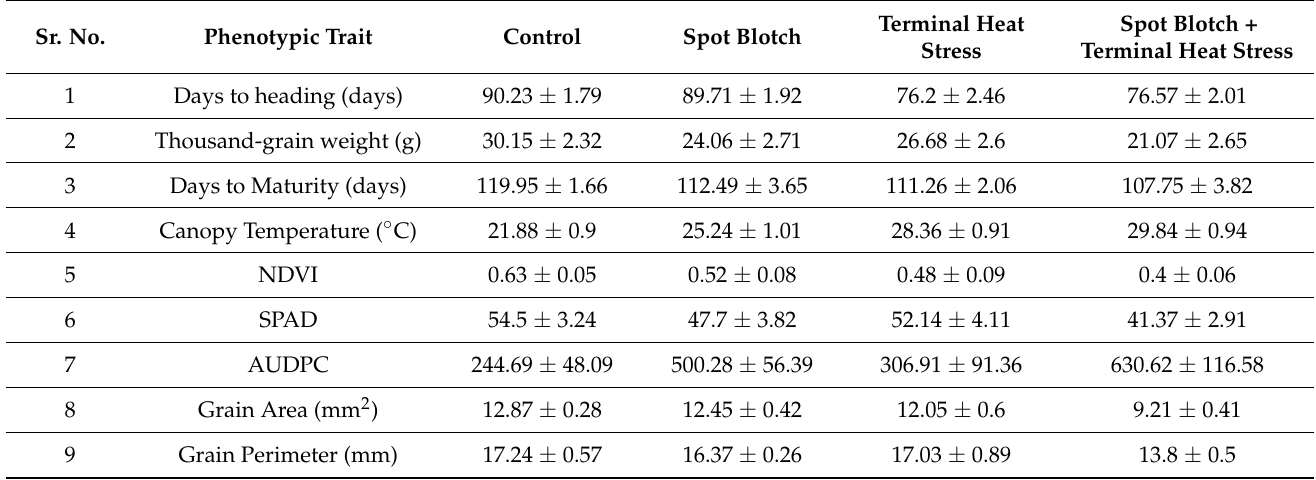
Table 1. Effect of biotic and abiotic stress on the performance of nine traits in wheat.